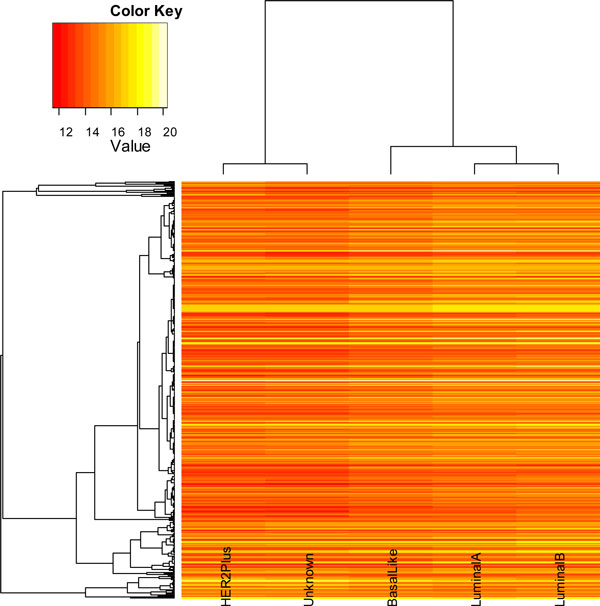
heatmap of protein change across four subtypes (luminal a, luminal b, her2+, and basal-like) and additionally unknown subtype. The y axis is protein markers. Each colored cell represents a protein intensity calculated by the Equation (5). The rows use hierarchical clustering with Euclidean distance. The columns use hierarchical clustering with protein intensity distance defined in the Equation (6).